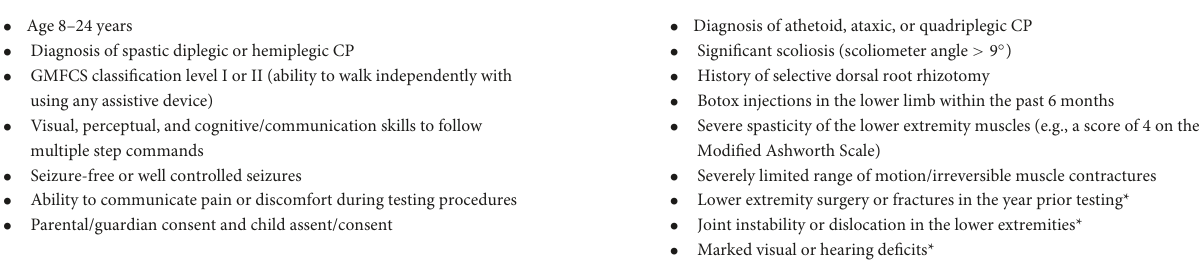
TABLE 1 Inclusion and exclusion criteria.